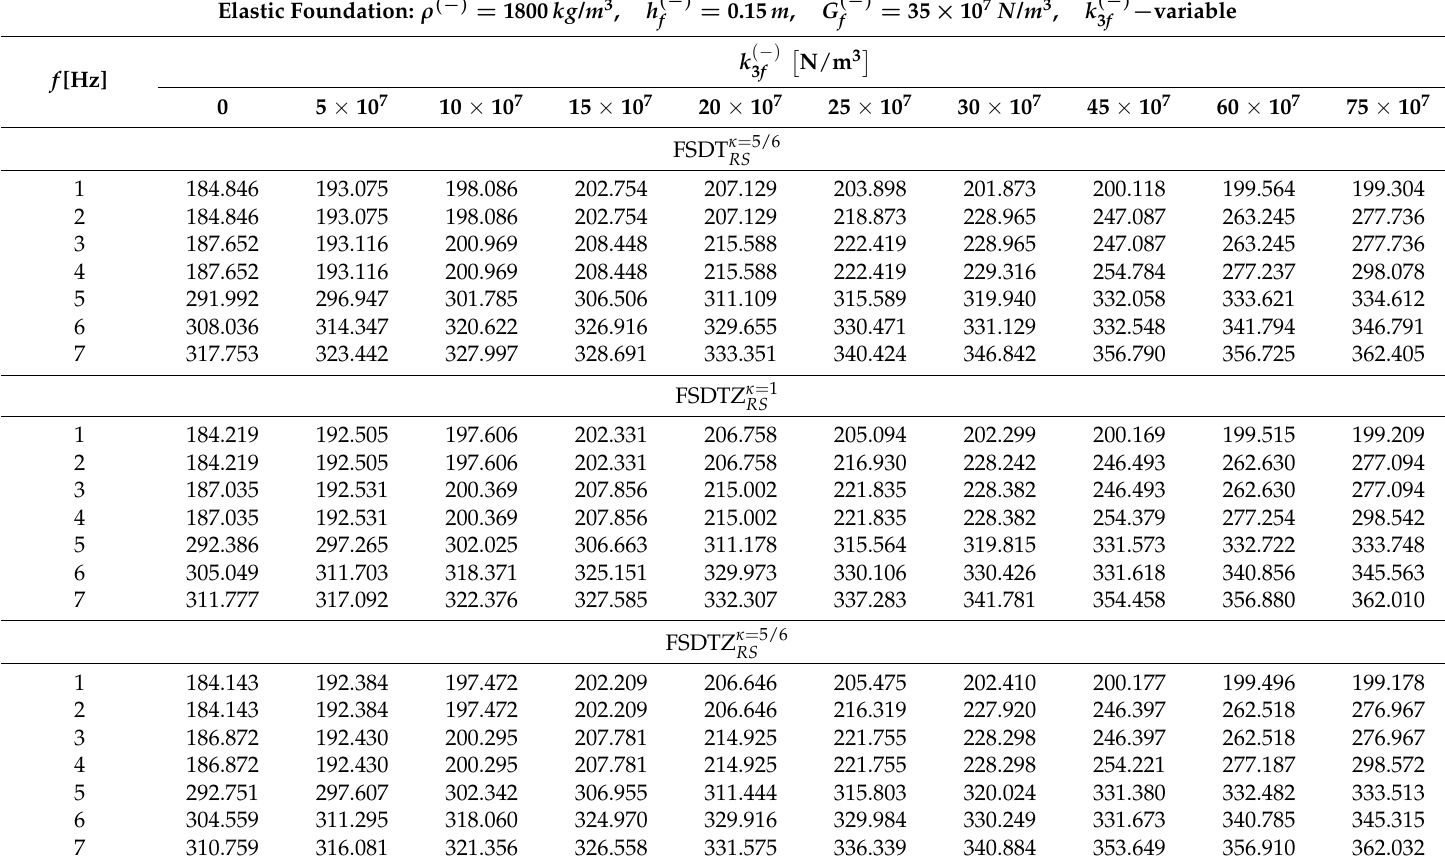
Table 6. First seven natural frequency variations of a CFCF cylindrical surface (Figure 4b) reinforced by CNTs distributed as in Figure 5b for the different theories. The mass fraction was w r = 0.25, and the agglomeration parameters µ 1 = 0.5 and µ 2 = 0.75. The Chebyshev-Gauss-Lobatto grid distribution was employed, with I N = I M =